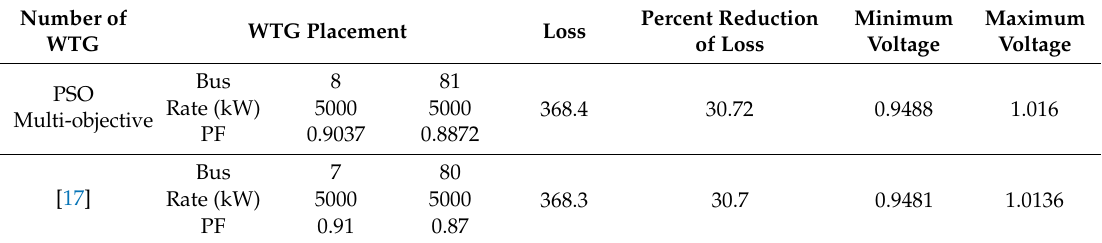
Table 7. Comparison results of the proposed method with Ref. [17], 84 bus